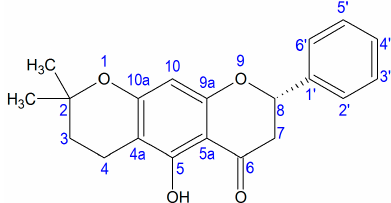
Figure 2. Compound 1c and its assigned numbers.